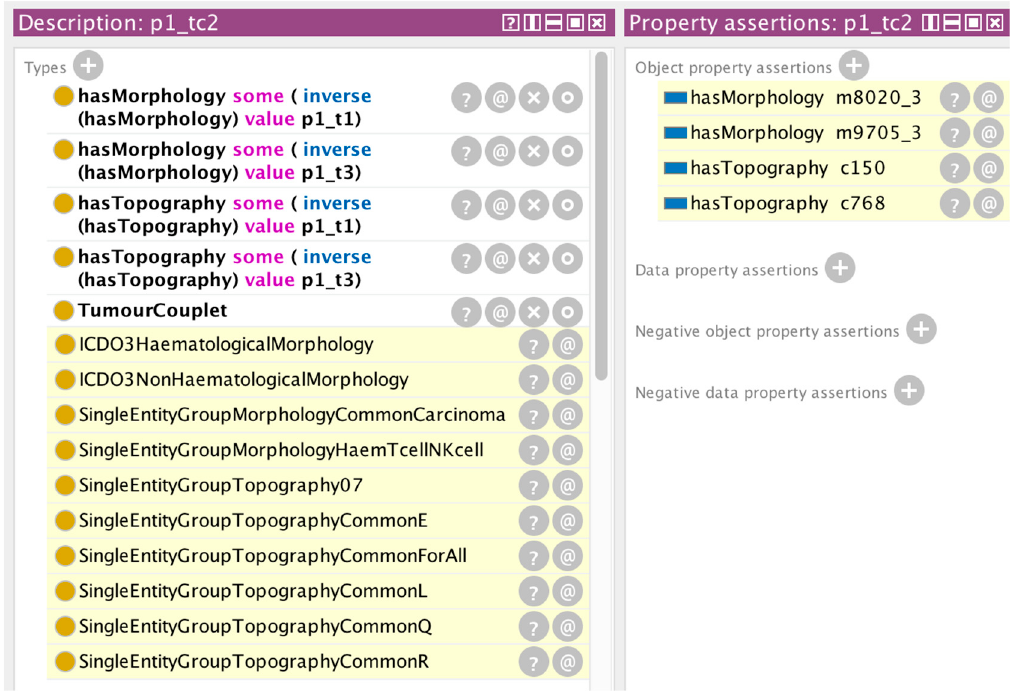
Figure 4. Results of the reasoning operation for the tumour couplet p1_tc2. Although the topography codes are equivalent via Axiom (4), the morphology codes are independent and the couplet is a valid MPT.